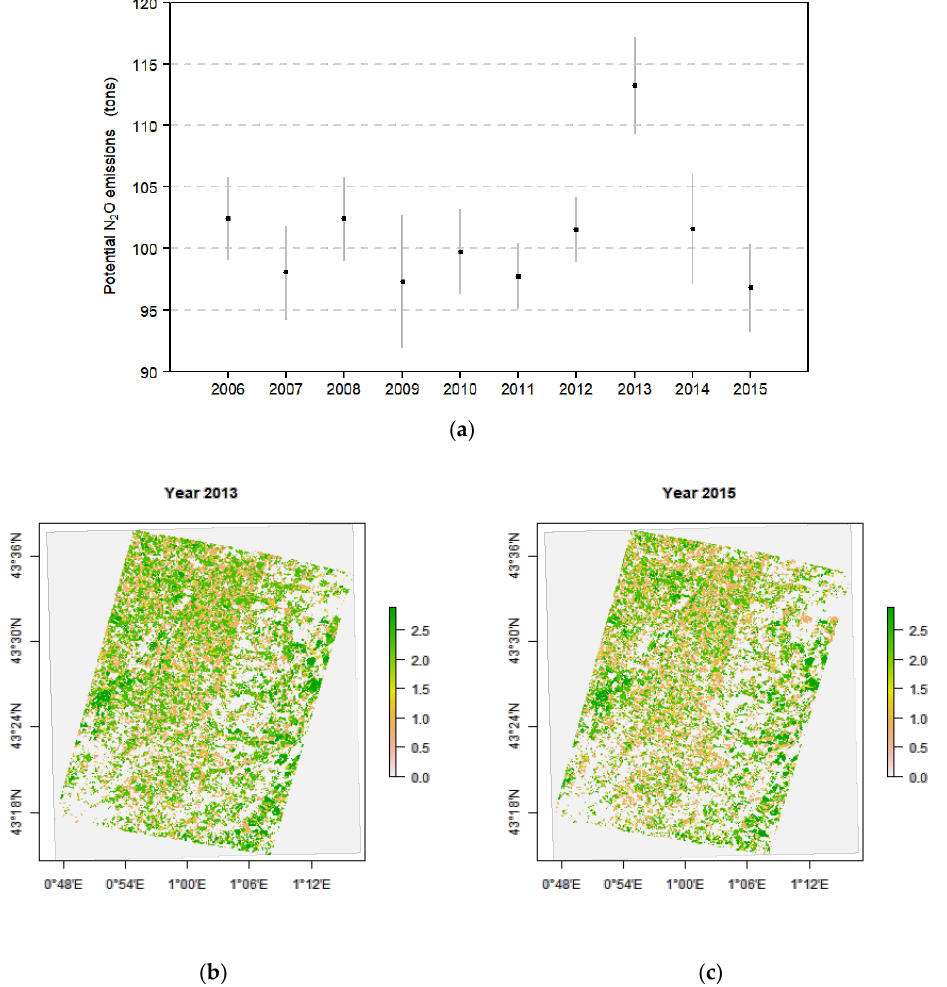
Figure 7. Time course of the yearly potential budget of N 2 O emissions estimated over the study area ( a ), together with the maps of potential N 2 O emissions (in kg of N 2 O) emitted per pixel derived from the classifications for the years 2013 and 2015 ( b , c , respectively).